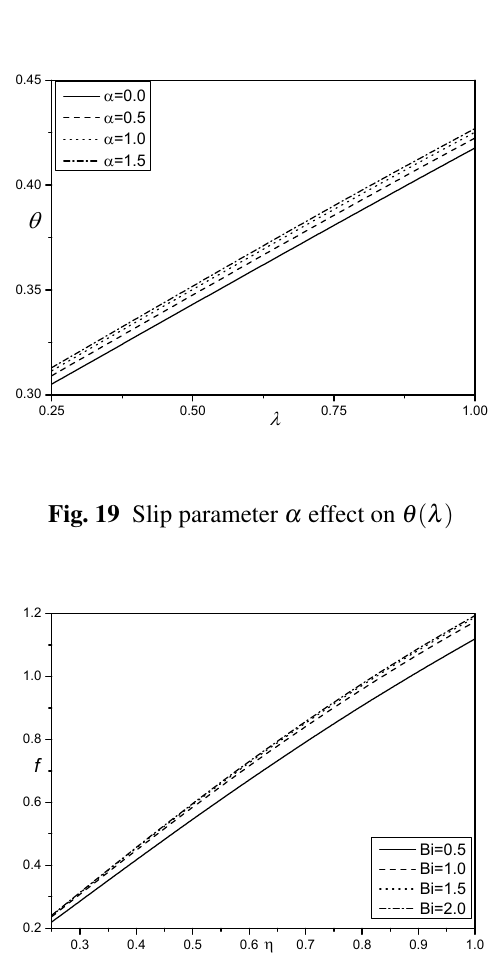
Fig. 18 Slip parameter α effect on f ( λ )